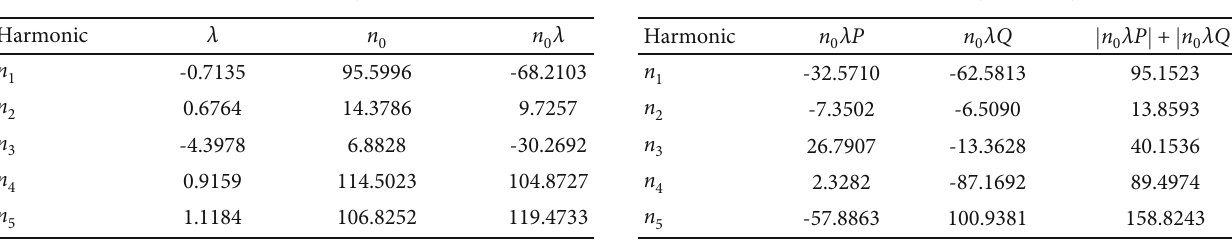
fi t (without A 0 ), and the model Table 3: Coe ffi cients n